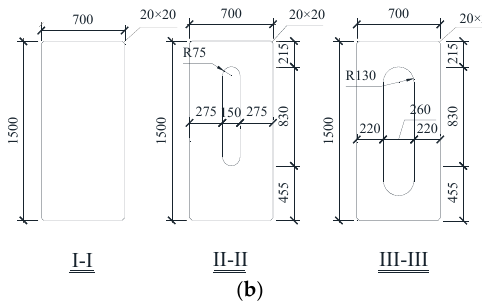
Figure 1. Detailed dimensions of the specimen (unit: mm): ( a ) Front of elevation; ( b ) sectional view.